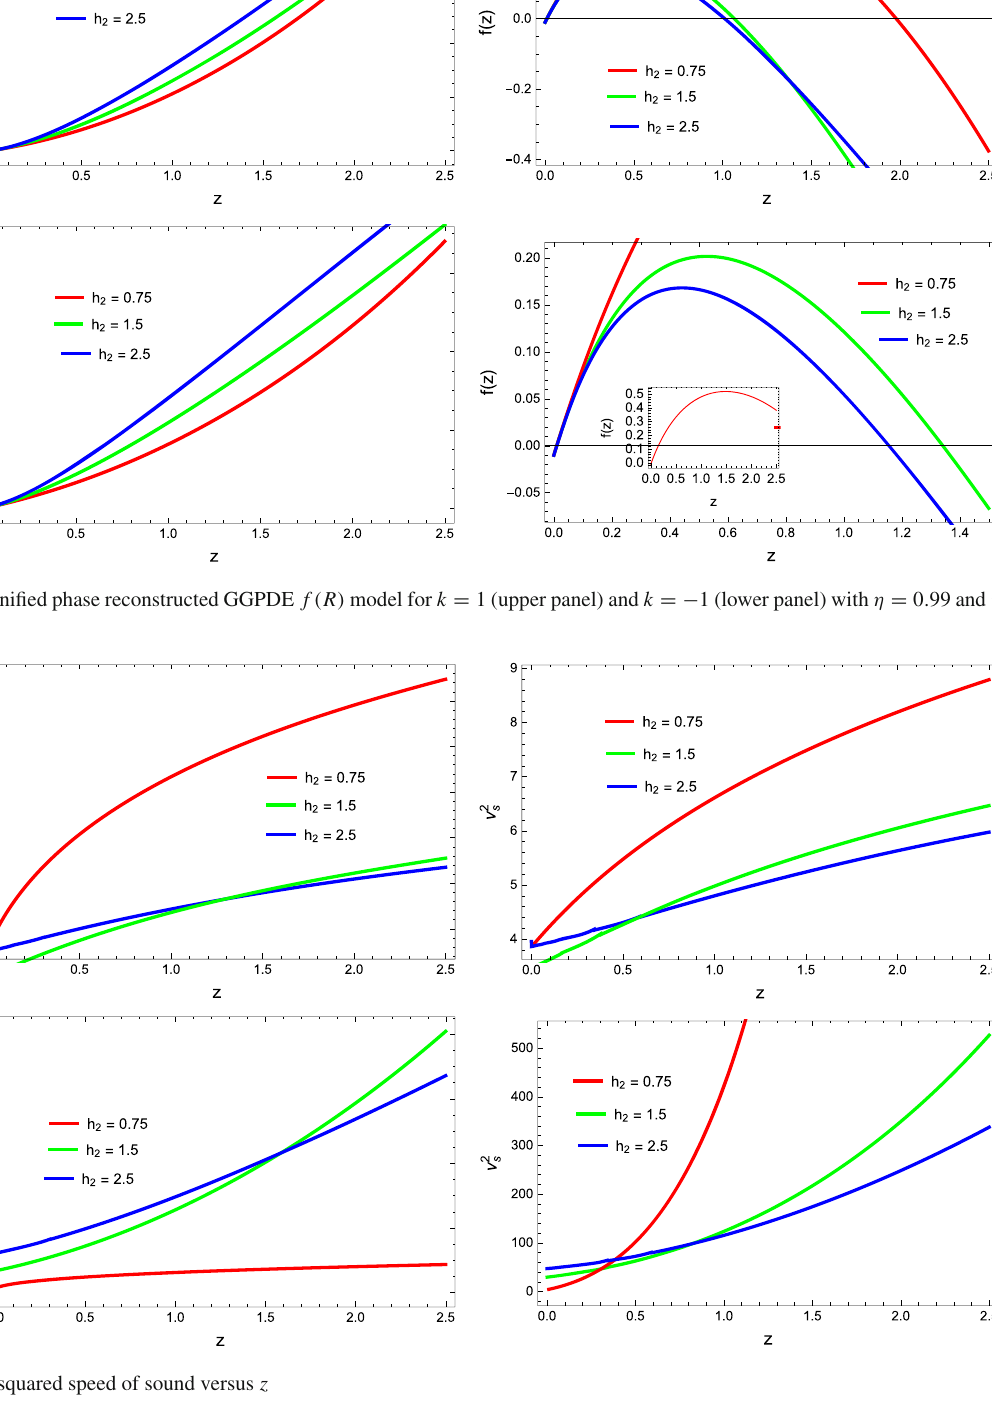
Fig. 9 Plots for squared speed of sound versus